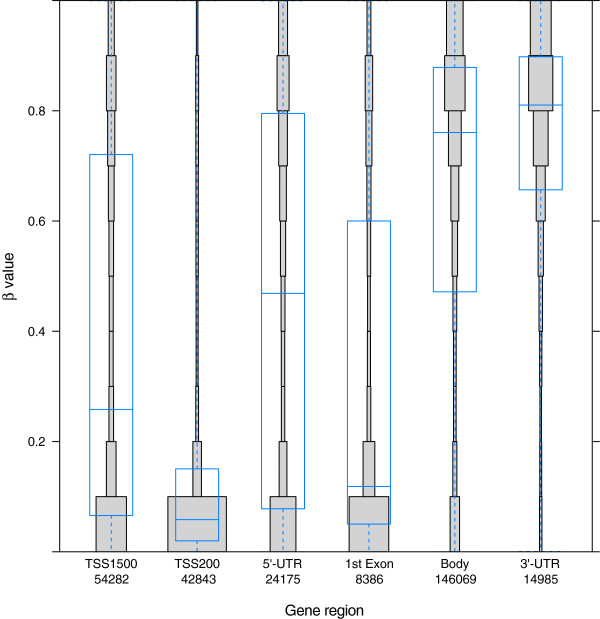
DNA methylation in specific gene regions. Distribution of DNA methylation in specific gene regions is shown. Each gene region is further divided into bins that correspond to beta values with 0.1 intervals. The area of each bin corresponds to total number of CpGs. The overall distribution and the mean of beta value of the CpGs in each gene region are shown as a box plot. The most unmethylated regions are associated with promoter sequences (TSS1500, TSS200, and 5′-UTR) and the first exon, while the most methylated regions are in the gene body and 3′-UTR. The numbers on the x-axis correspond to total number of CpGs in each gene region; also the x-axis shows different gene regions, and the y-axis shows the beta values.